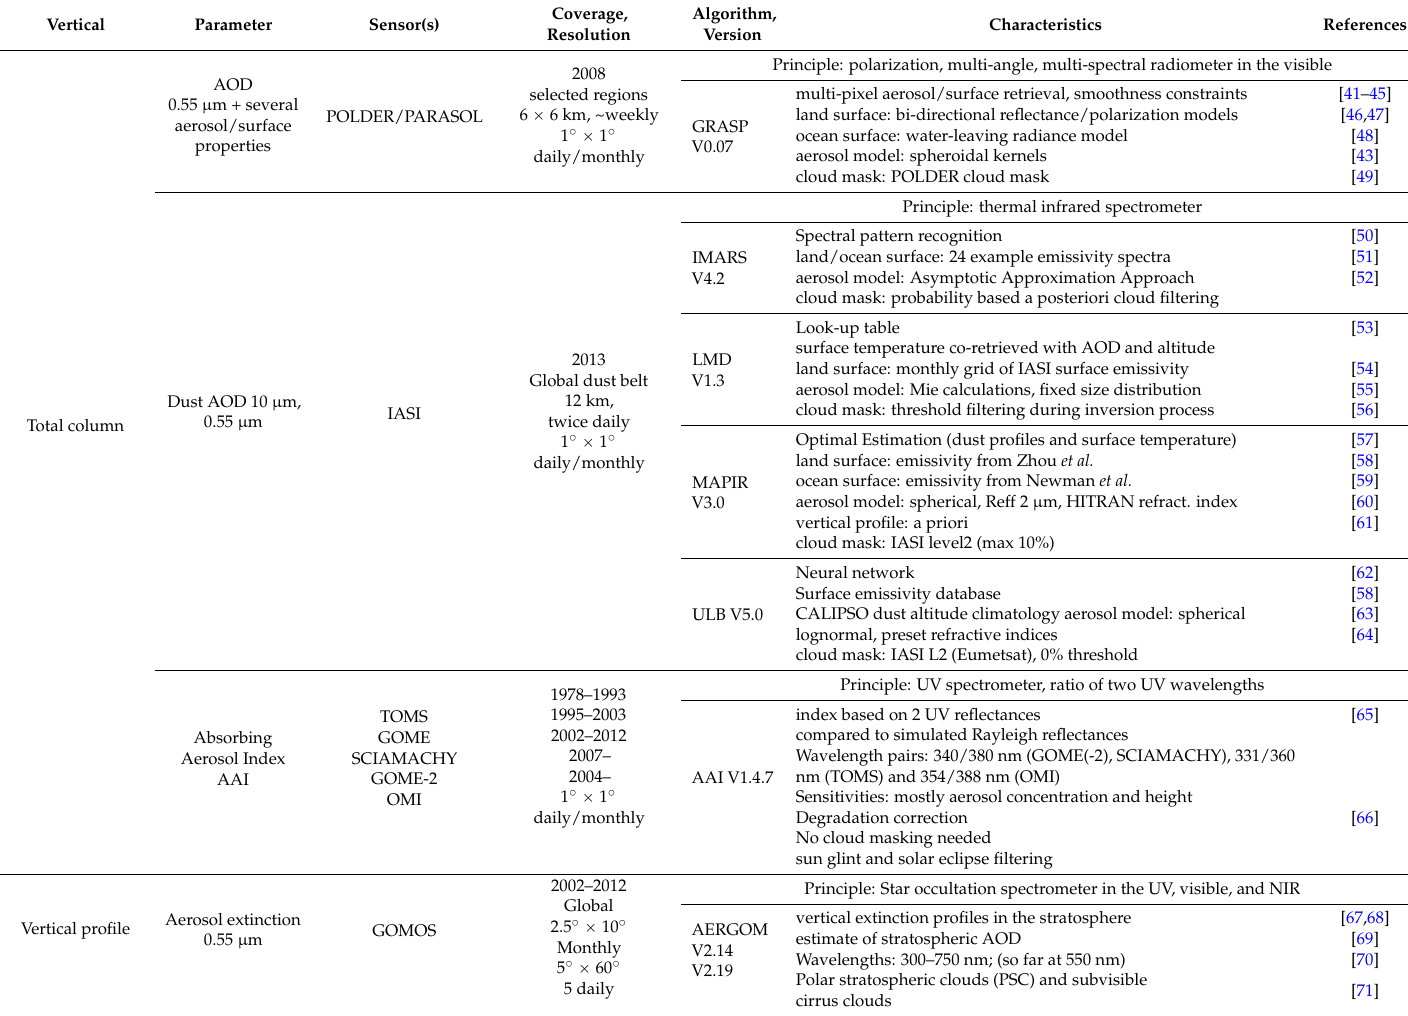
Table 9. Overview of further data sets and algorithms discussed in this